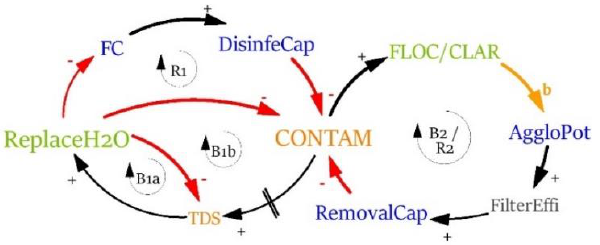
Figure 9. Five feedback loops extracted from Figure 8 illustrating two strategies to remove contam- inants in